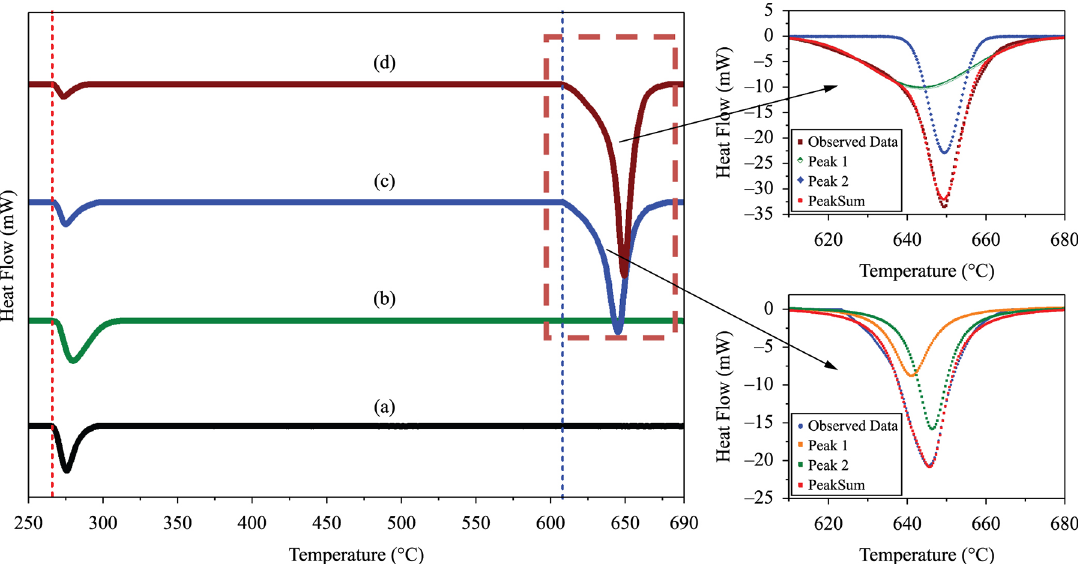
Figure 3. DSC Plots of heating cycle of different compositions of alloy (a) Bi prepared at 140 °C for 12h with MR of precursor/NaBH peaks of Bi Sb and Bi Sb respectively, observed on the right end 0.50 0.50 0.25 0.75